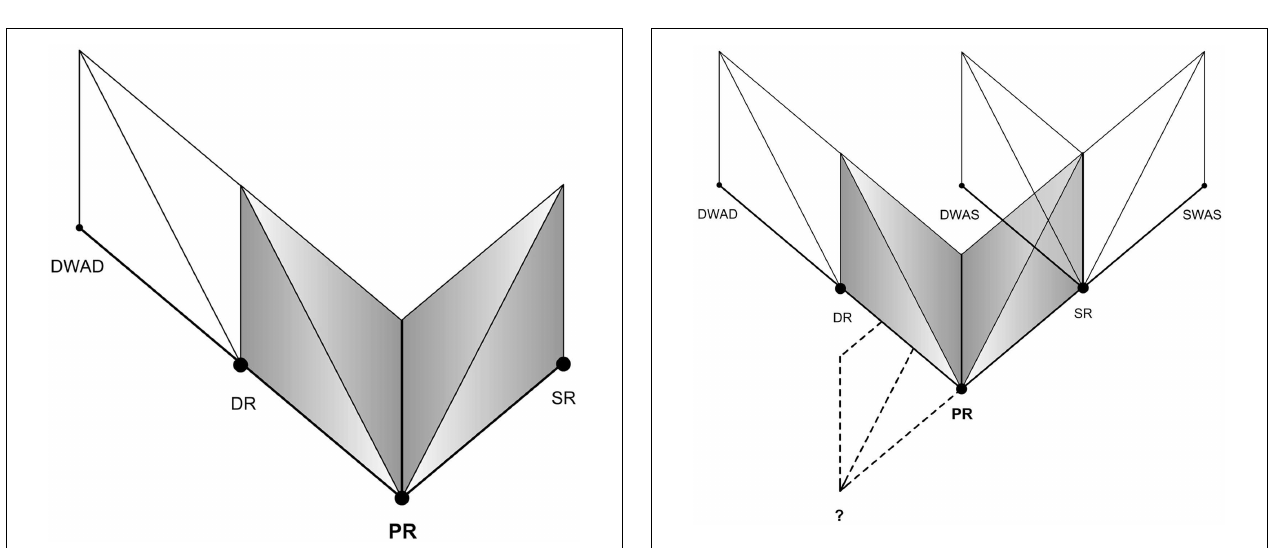
FIGURE 13 | Dream within a dream.